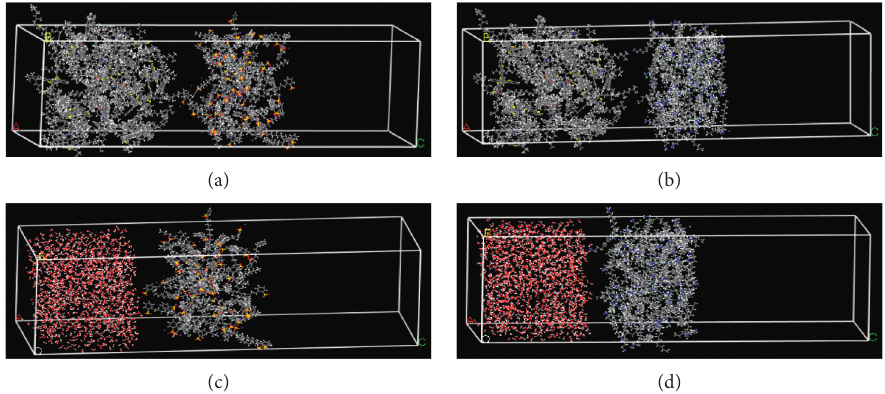
Figure 4: The interface between emulsifier and asphalt binder/water: (a) asphalt binder vs. cationic emulsifier; (b) asphalt binder vs. anionic emulsifier; (c) water vs. cationic emulsifier; (d) water vs. anionic emulsifier.